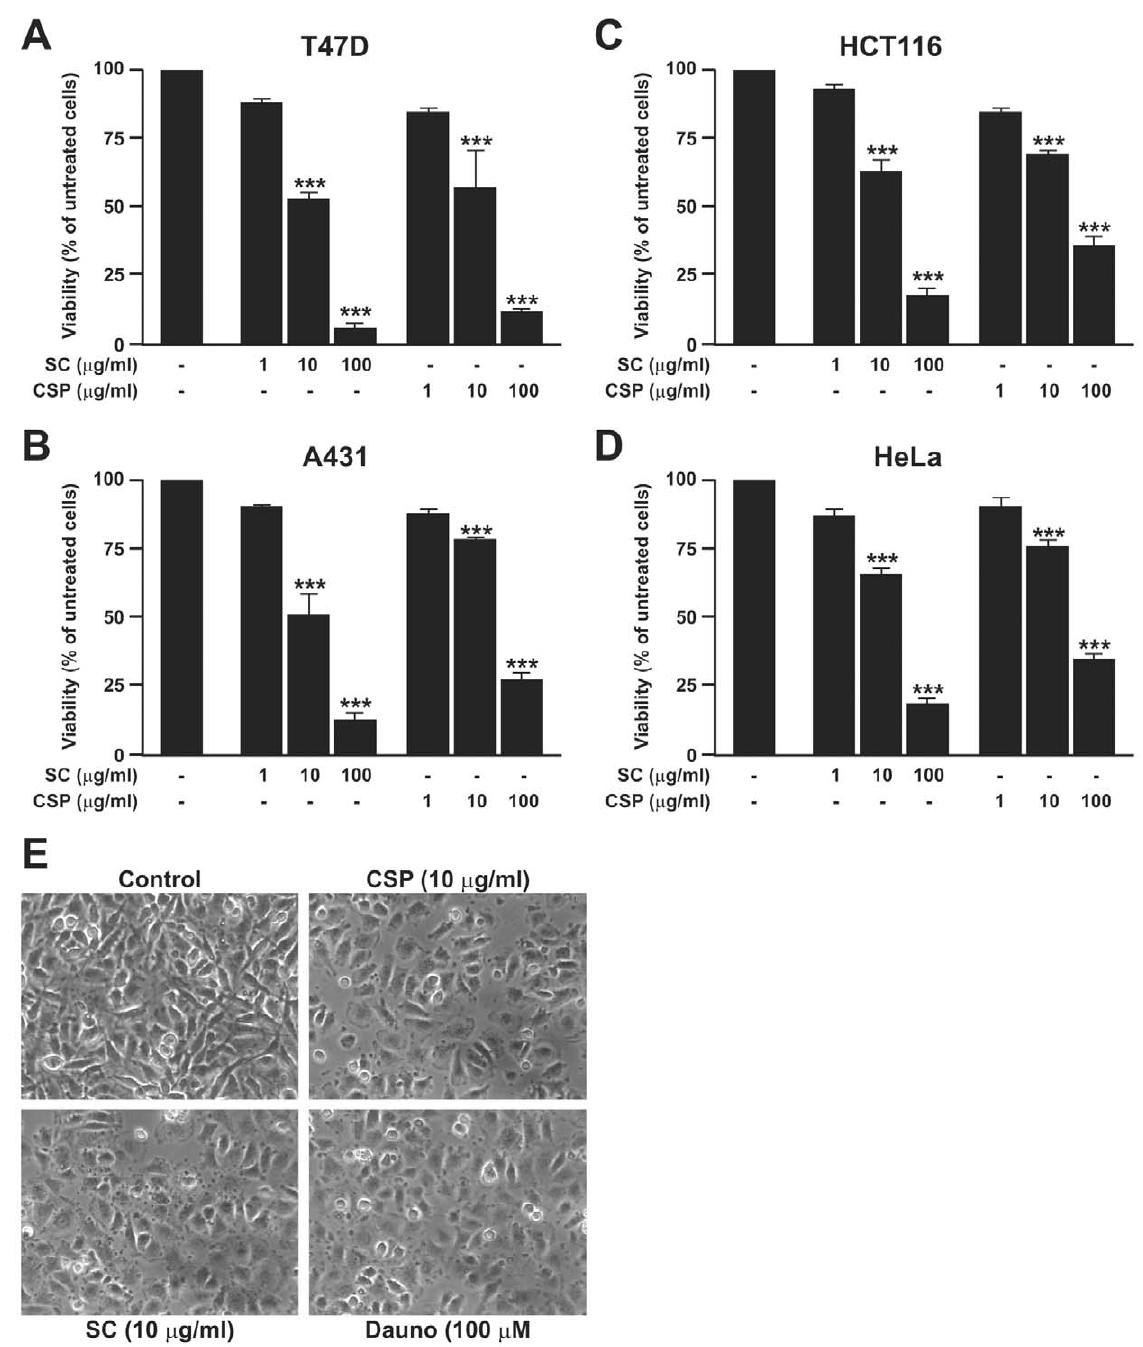
Figure 2. Effect of SC and CSP on cell viability and morphology. T47D (A), A431(B), HCT116(C) and HeLa (D) cells were incubated with SC (1, 10 and 100 m M) and CSP (1, 10 and 100 m M) for 24 h. Thereafter cell viability was determined by MTT assay as described in Materials and Methods. Data are expressed as mean 6 S.E.M. of six separate experiments (***p , 0.001 vs. untreated cells). T47D cells (E) were treated with SC (10 m g/ml), CSP (10 m g/ml) or Dauno (100 m M) for 24 h, visualised by phase-contrast microscopy and photographed. The untreated cells (Control) exhibited normal morphologic aspects, whereas the cells treated with CSP, SC and Dauno were suggestive of apoptosis. Data illustrated in (C) are from a single experiment and are representative of three separate experiments. doi:10.1371/journal.pone.0033031.g002 effect of SC and CSP on the DY m . As shown in Figure 4A, two ed as well as vehicle-treated cells. CisPt exhibited the same effect different human carcinoma cell lines treated overnight with SC (Figure 4A). To investigate the involvement of apoptotic signalling and CSP showed a significant and concentration-dependent loss of molecules following SC and CSP treatment, the expression level of the mitochondrial transmembrane potential compared to untreat- apoptosis related proteins were analyzed by means of an antibody